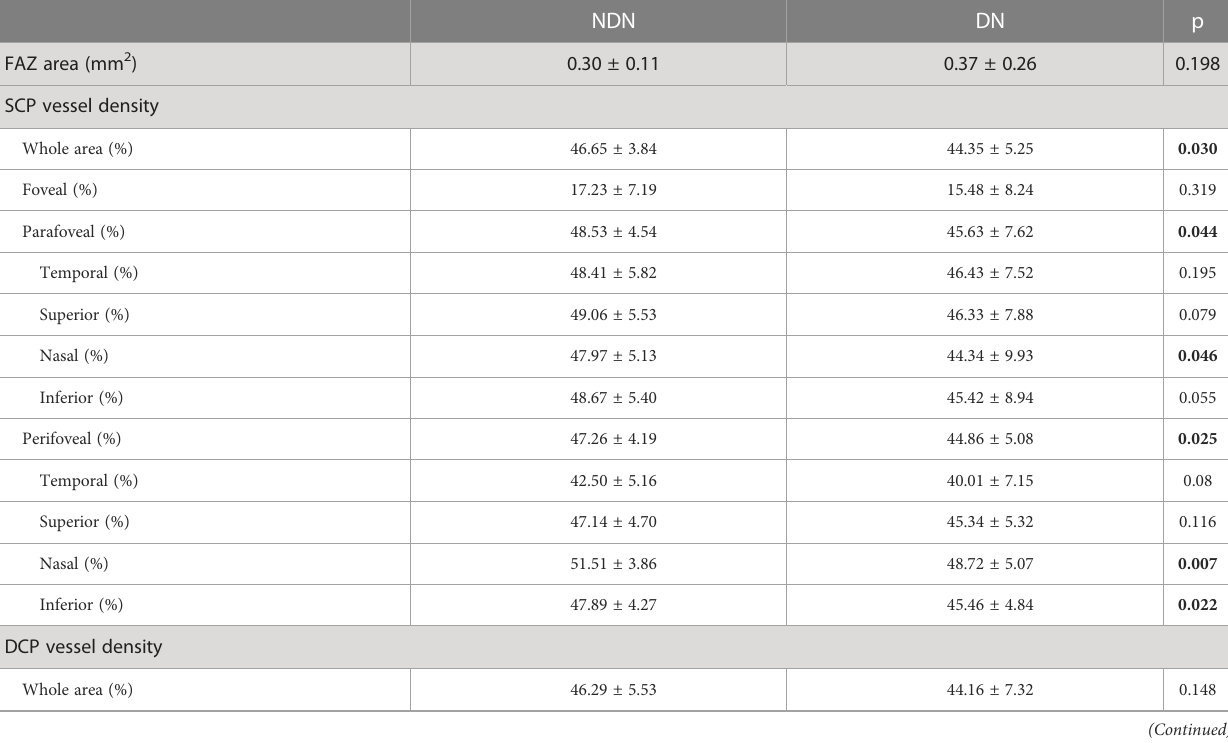
TABLE 2 Vessel density in the macular